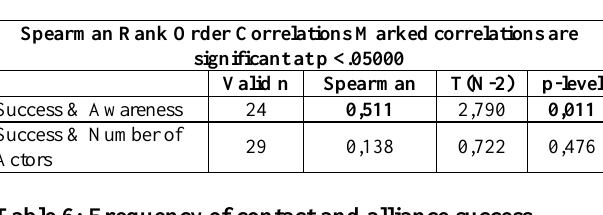
Table 5: Community awareness, number of actors and alliance success